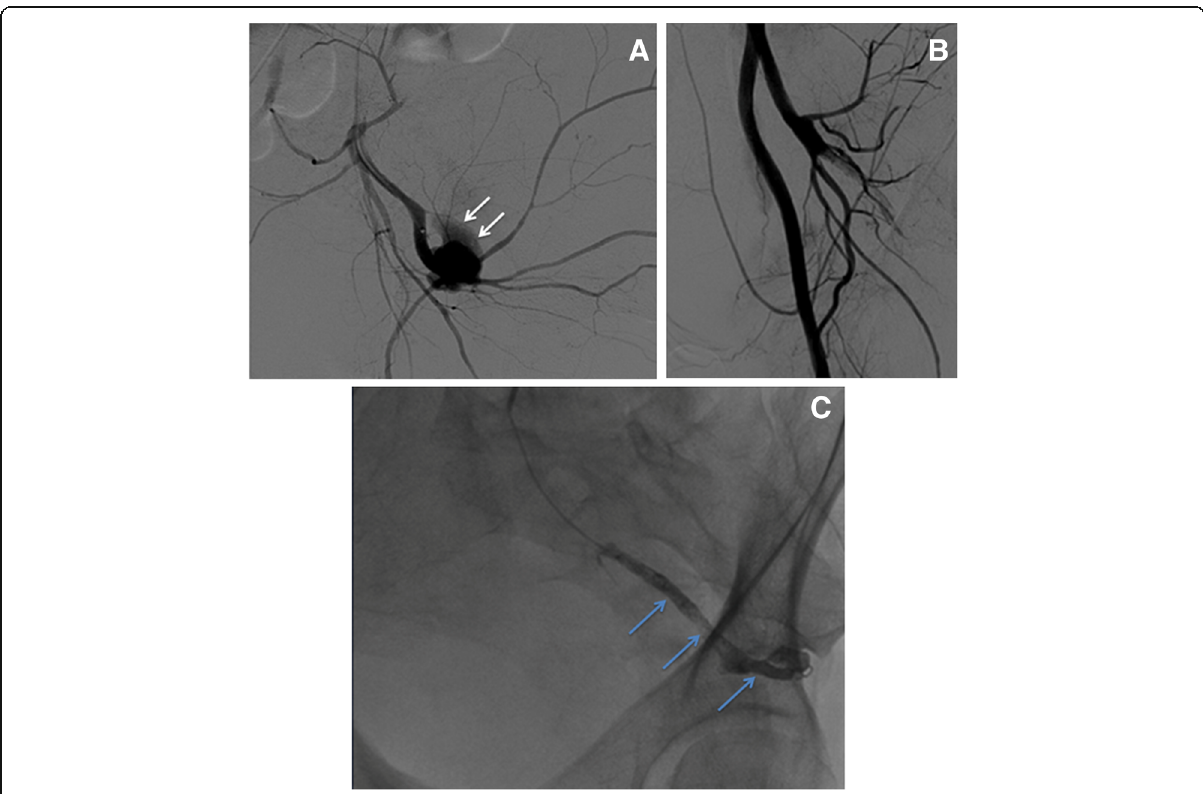
Fig. 5 Iatrogenic acute arterial bleeding embolization. a Diagnostic DSA shows a significant contrast extravasation (white arrows) due to active arterial bleeding of a branch of the left hypogastric artery. b Progressive embolization with PVA particles and Squid-18. c After embolization, the bleeding vessel completely filled of Squid (light blue arrows)